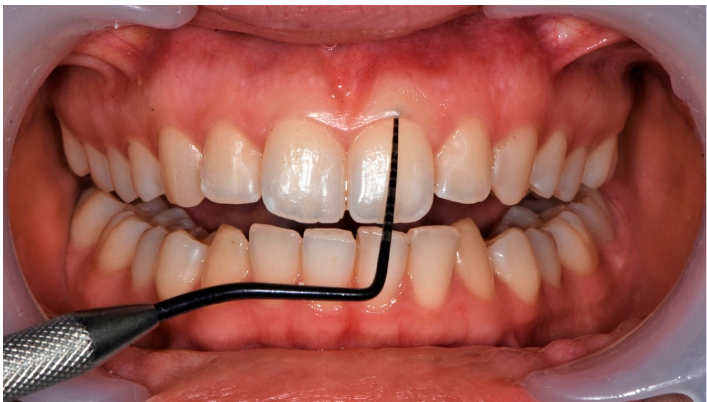
Figure 2. Measurement of gum phenotype according to De Rouck T. et al.